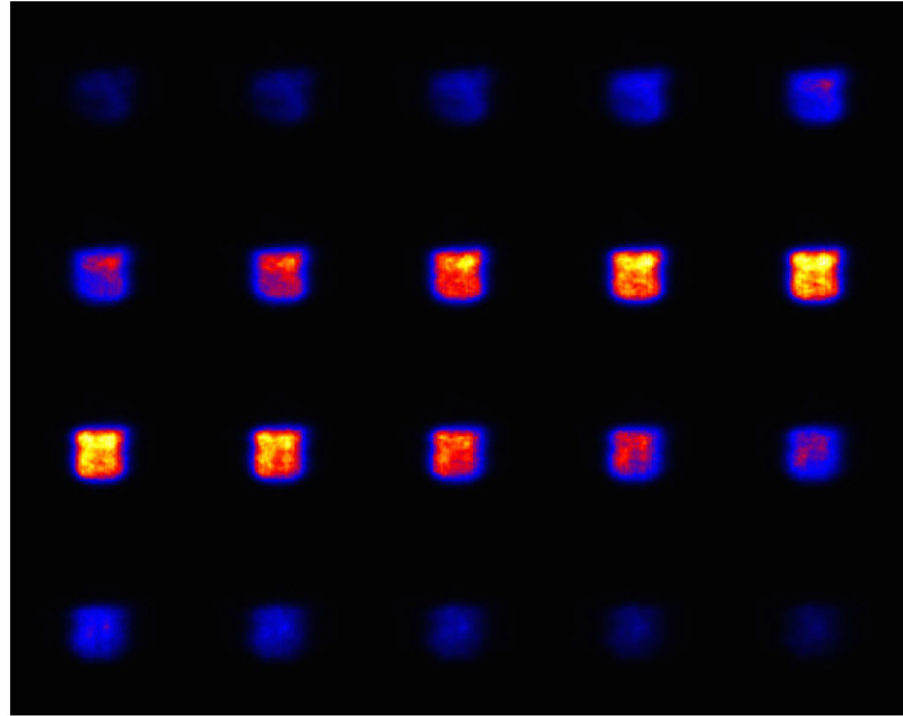
Figure 2. 2-D slices of the plane source image. Each figure shows 0.8 mm pitch slice in the Z-Y plane.